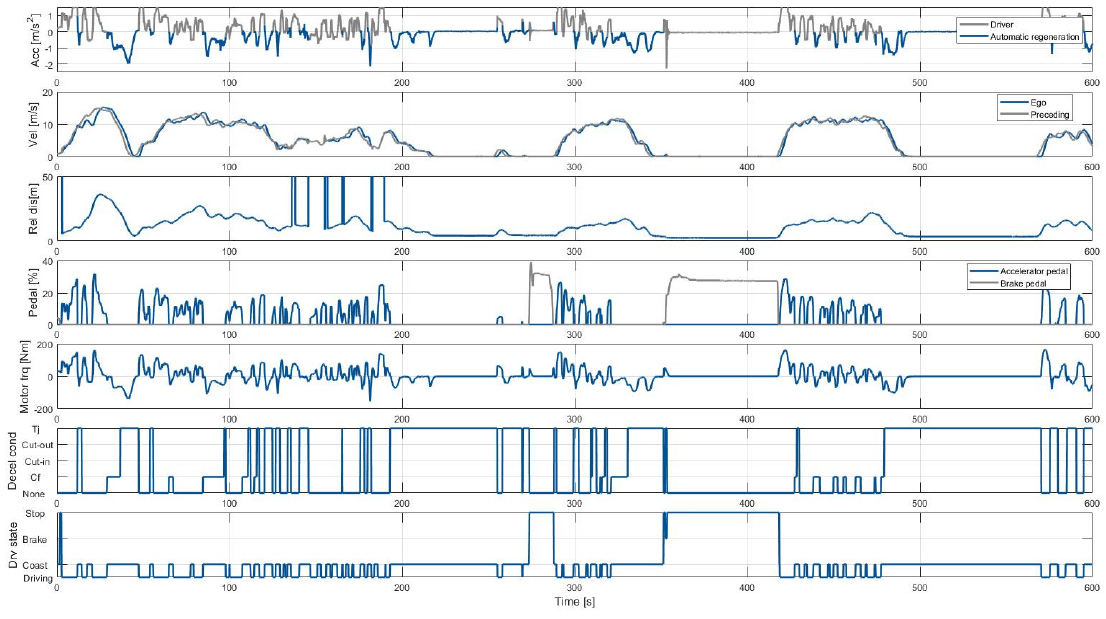
Figure 15. Vehicle test results on urban roads.